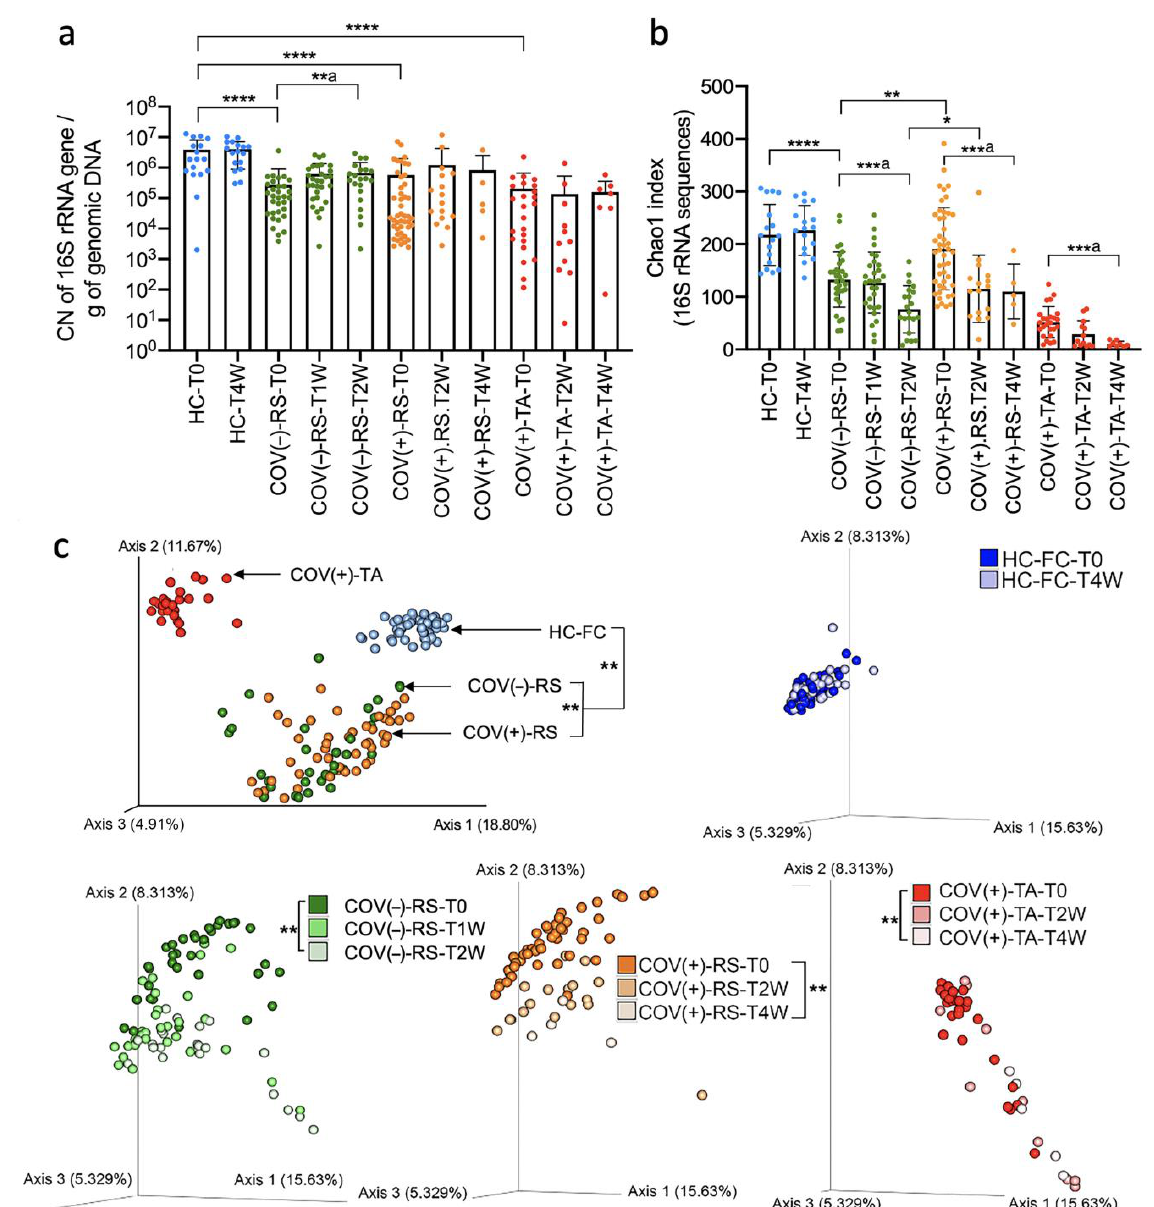
Figure 3. Dynamics of the gut and respiratory bacterial load and diversity. ( a ) Bacterial load in critically ill patients as assessed by qPCR of the V4 region of the 16S rRNA gene at ICU admission and over time spent in the ICU. * p < 0.05, ** p < 0.001, *** p < 0.0001, **** p < 0.0001, Mann – Whitney test unless three groups were tested, then Kruskal – Wallis test was applied (a). ( b ) Bacterial richness as assessed by the Chao1 index analysis of the 16S rRNA sequences upon ICU admission, and progressive decrease in this richness in both the gut and respiratory microbiome from admission day to 2 weeks for ICU-COV (−) patients, up to 4 weeks for ICU-COV(+) patients, one fecal sample at baseline and one 4 weeks later for HCs. a. Kruskal – Wallis test and ANOVA test for more than two groups and non-parametric or parametric data, respectively. ( c ) Beta-diversity analyses using unweighted UniFrac Principal Coordinate Analysis (PCoA). T0 = baseline; T1W = sample collected 1 week after baseline; T2W = sample collected after 2 weeks after baseline; T4W = samples collected after 4 weeks after baseline. ** p < 0.005, 5 PERMANOVA test (adonis2 function). ICU = intensive care unit; COV (−) = COVID-19-negative; COV(+) = COVID-19-positive; RS = rectal swab; TA = tracheal aspirate.